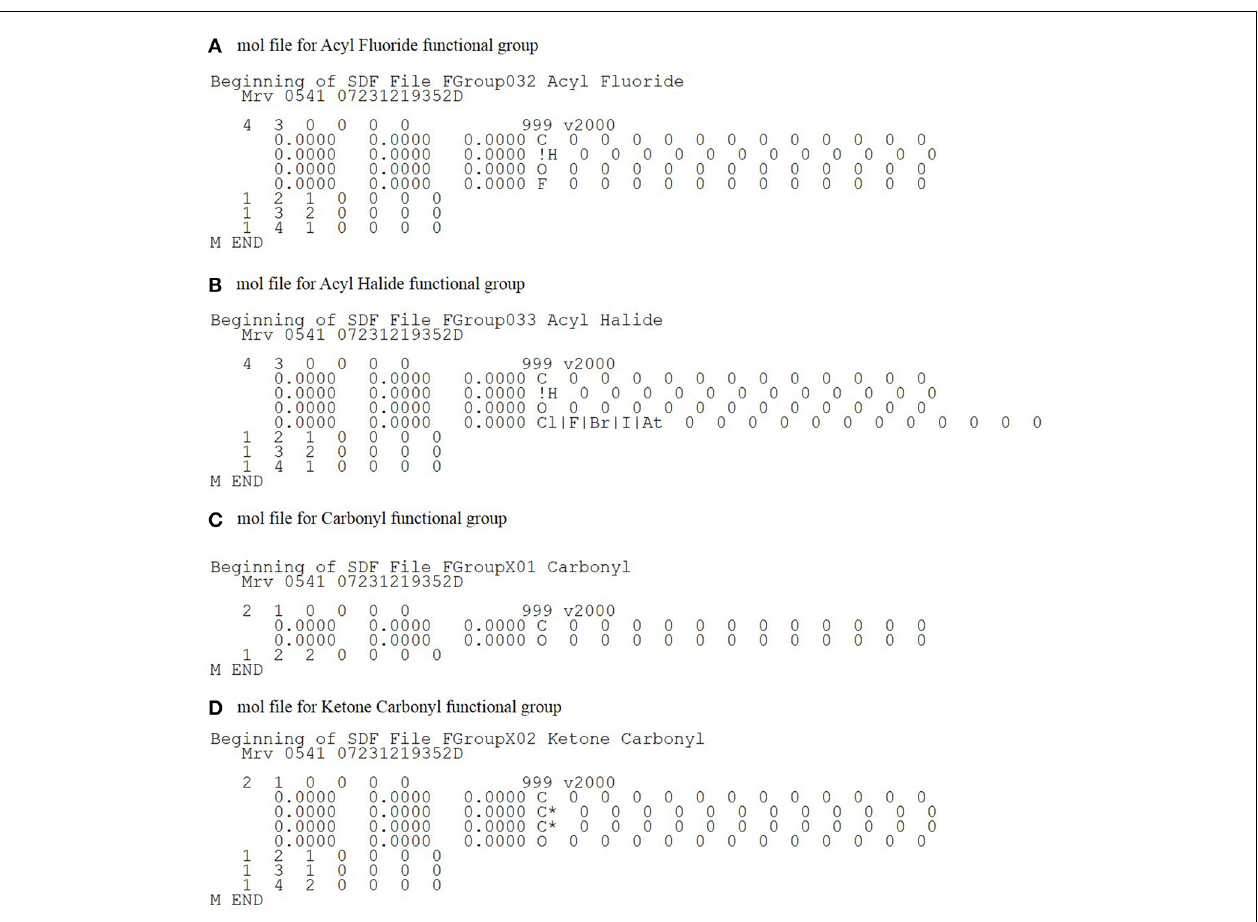
FIGURE 2 | Example functional group molfile files. (A) The functional group molfile file for acyl fluoride demonstrates the use of the !X element type. The !H element type for atom 2 designates that it can be validly mapped to any non-hydrogen element type atom. (B) Similar to acyl fluoride, acyl halide uses the !H to designate a non-hydrogen element type.